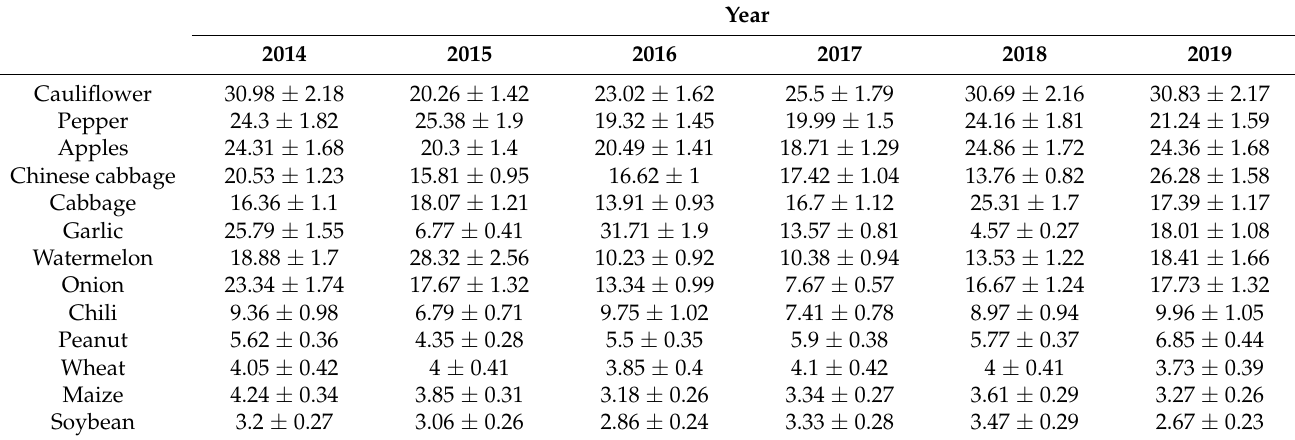
Table 5. Economic efficiency of total water in 2014–2019.